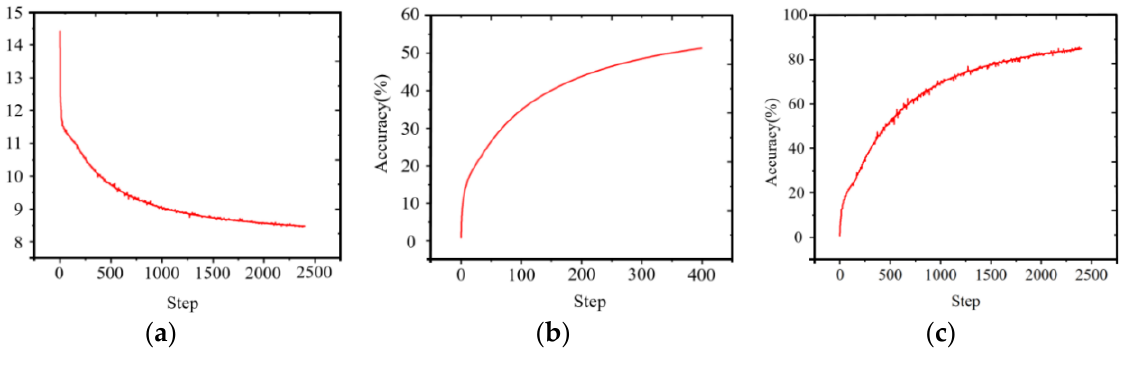
Figure 3. The result for the training